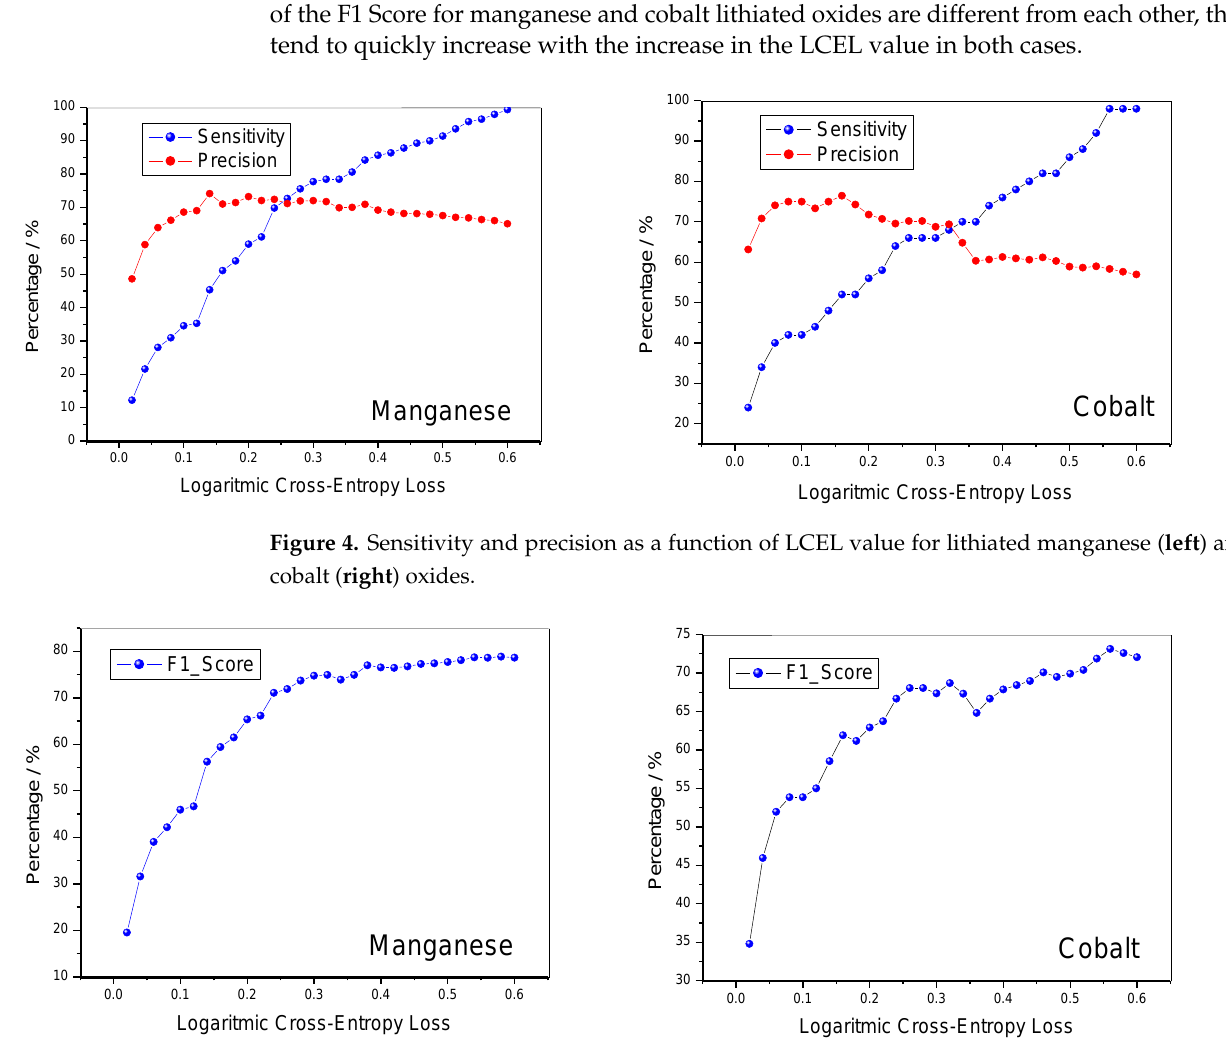
Figure 6. Selectivity and accuracy as a function of LCEL value for lithiated manganese ( left ) and cobalt ( right ) oxides. 0.0